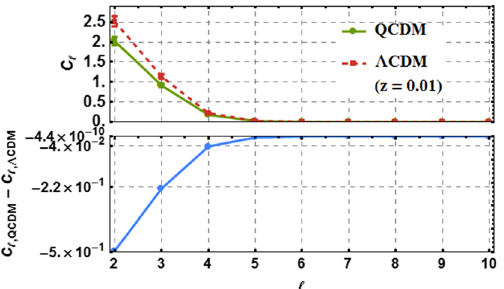
Fig. 5 Top: luminosity distance power spectrum C (cid:11) at z = 0 . 05 with integration ranging from k = 10 − 4 to 0 . 1 Mpc − 1 h for each (cid:11) = 2 to 10. Bottom: residue of the luminosity distance power spectrum between QCDM and (cid:4) CDM